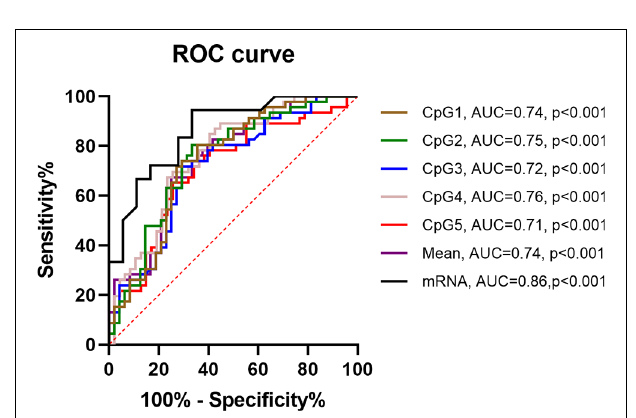
FIGURE 6 | ROC curves of PNPLA6 DNA methylation in IA patients. ROC, receiver operating characteristic. AUC, area under the curve.